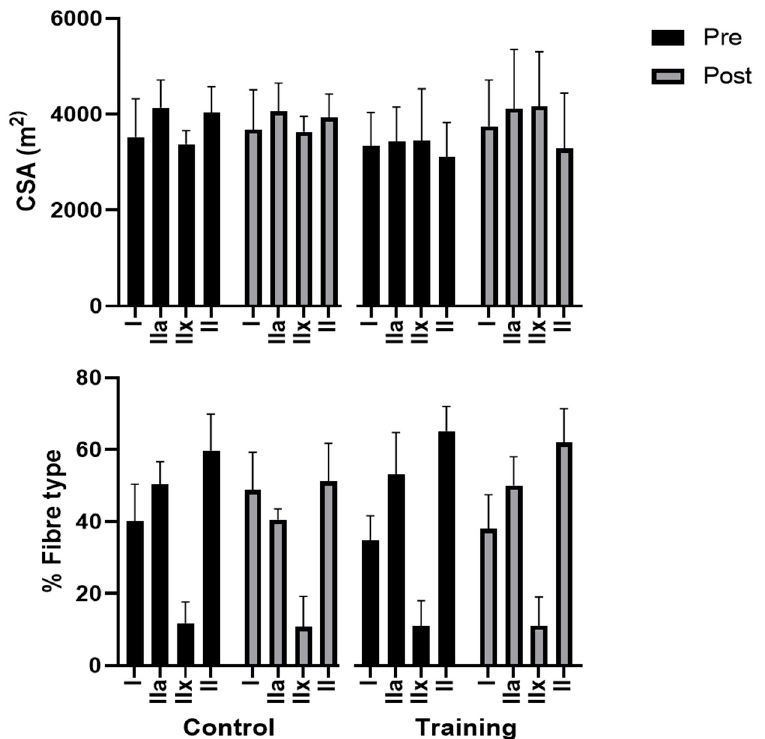
Figure 6. Muscle fibre type cross-sectional area ( µ m 2 ) and percentage (%) of vastus lateralis muscles before and after 8 weeks of plyometric jump training. II indicates MHC-IIx + IIa fibres; IIx indicates MHC-IIx fibres; IIa indicates MHC-IIa fibres; I indicates MHC-I fibres.